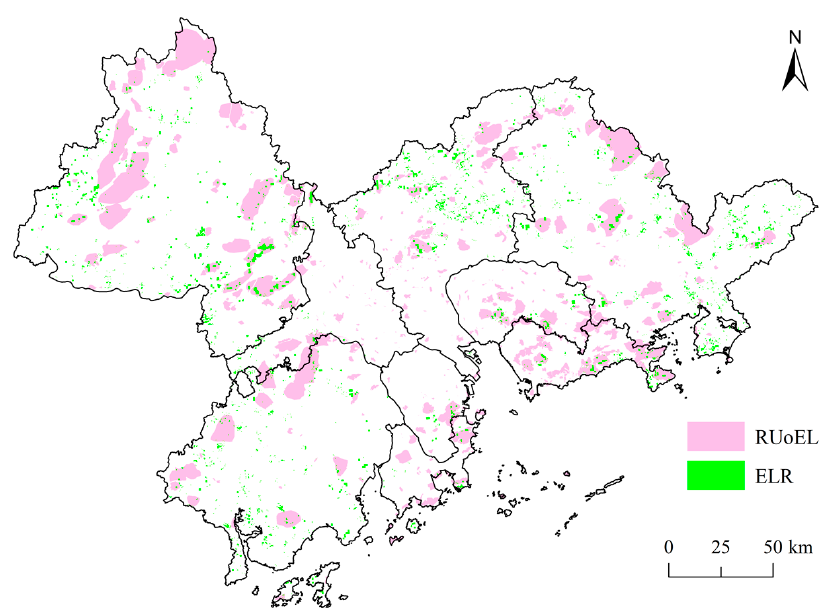
Figure 7. Spatial distribution of the ecological land restoration (ELR) patches and the recreational use of ecological land (RUoEL).